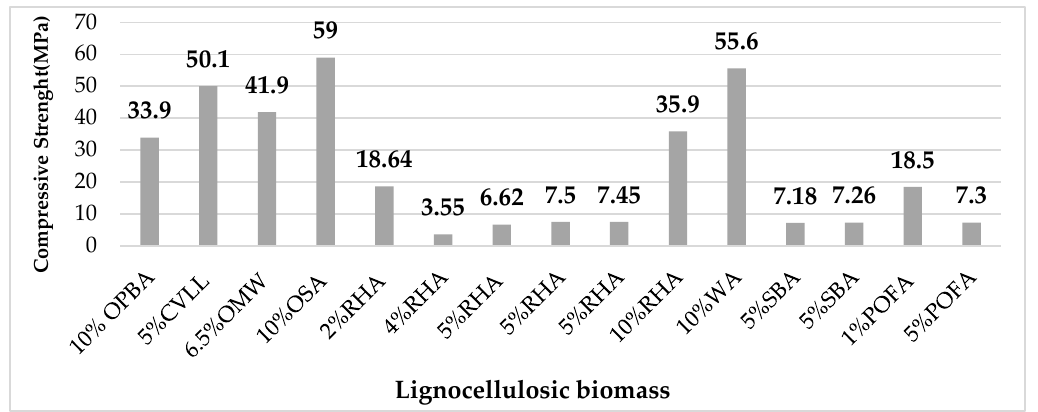
Figure 7. Compressive strength for samples made with lignocellulosic biomass ash: 10% OPBA [60], 5% CVLL [61], 6.5% OMW [63], 10% OSA [62], 2% RHA [32], 4% RHA [31], 5% RHA [64], 5% RHA [67], 5% RHA[68], 10% RHA [65], 10% WA [65], 5% SBA [67], 5% SBA [68], 1% OPFA [70], 5% OPFA [69].